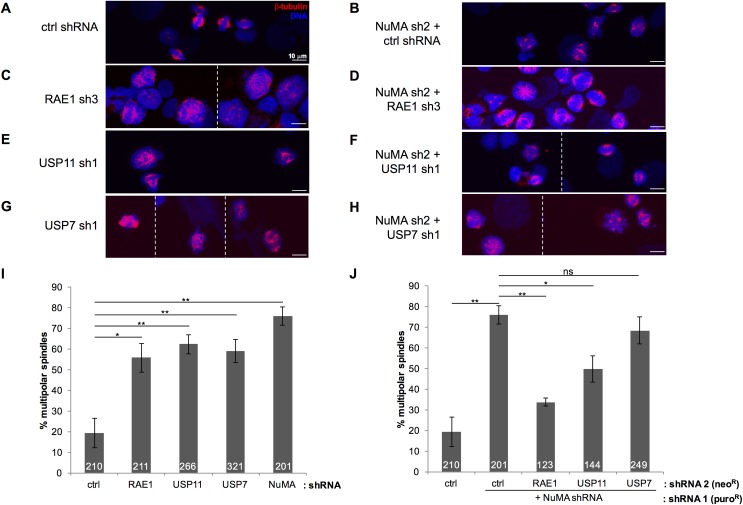
Knock-down of USP11 restores bipolar spindle formation in NuMA shRNA transduced cells.(A-H) Representative images of U2OS cells expressing the indicated shRNAs released from nocodazole arrest for 90 min, immunostained for ß-tubulin. Z-stacks were projected into 1 image. The striped line indicates separate images. (I) Percentage of multipolar spindles observed in cells expressing the indicated shRNA. The total number of counted cells is indicated in the bars for each shRNA. (J) Percentage of multipolar spindles expressing the indicated shRNA in combination with knock-down of NuMA. The total number of counted cells is indicated in the bars for each shRNA. Averages and SEMs are shown; ns: not significant, p > 0.05; * 0.01< p < 0.05; ** 0.001 < p < 0.01. The actual p-values for n biological replicates are, compared to control shRNA treated cells (n = 4): USP11sh1 (n = 4, p-value = 0.0036); USP7sh1 (n = 3, p-value = 0.0070); RAE1sh3 (n = 3, p-value = 0.0155); NuMAsh2 + control shRNA (n = 3, p-value = 0.0014); and compared to NuMAsh2 + ctrl shRNA treated cells: USP7sh1 + NuMAsh2 (n = 2, p-value = 0.457); NuMAsh2 + RAE1sh3 (n = 3, p-value = 0.0043), and NuMAsh2 + USP11sh1 (n = 3, p-value = 0.0317).